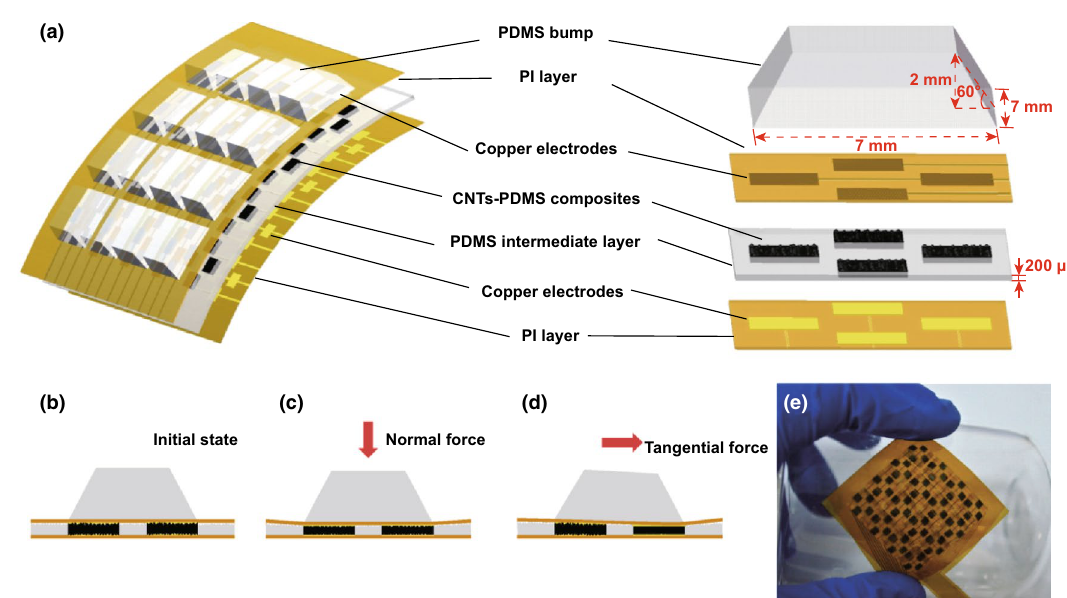
Fig. 1 a Dismantling structure schematic diagram of the tactile sensor array and one single element. b – d Cross-sectional diagrams of a tac- tile sensor element under initial state, normal force state and tangential force state, respectively. e Photograph of the sensor array attached to a curved